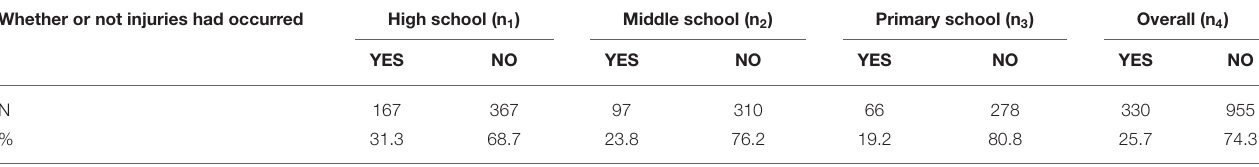
TABLE 2 | Injury occurrence during campus football activities.